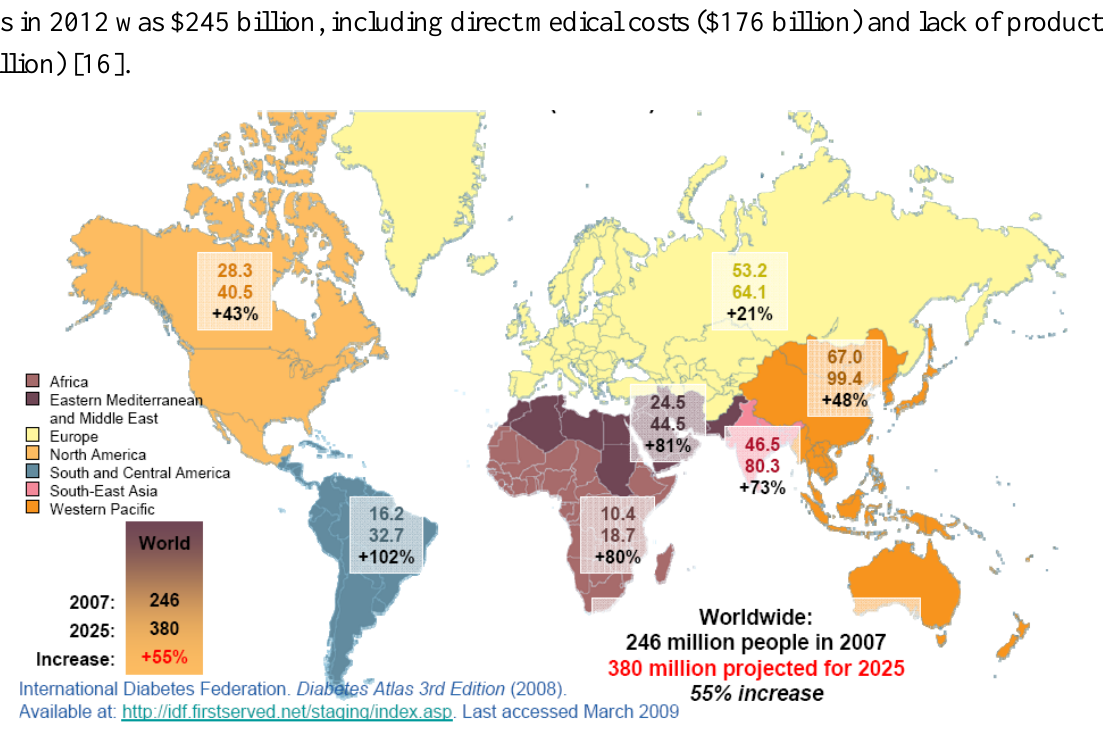
Figure 1. World expansion of diabetes mellitus, International Diabetes Federation